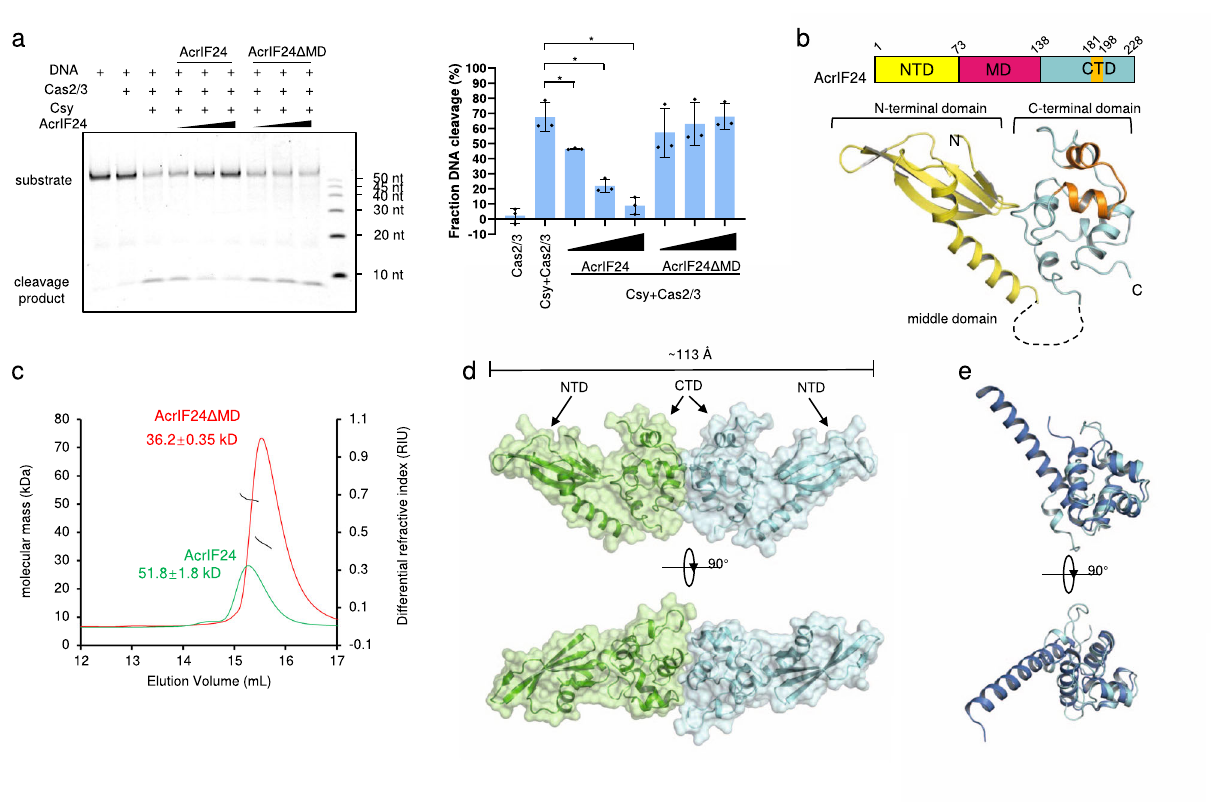
Fig. 1 The crystal structure of AcrIF24, a dimer that inhibits the type I-F CRISPR-Cas system. a AcrIF24 but not AcrIF24 Δ MD inhibits the in vitro cleavage activity of the type I-F CRISPR-Cas system. Reactions were performed with 0.32 μ M Csy complex, 0.16 μ M Cas2/3, and 0.04 μ M 54-bp dsDNA (5 ′ -FAM in the non-target DNA strand, NTS). AcrIF24 or AcrIF24 Δ MD was added with concentrations of 0.16, 0.32, and 0.64 μ M following the order indicated by the black triangles. Fraction DNA cleavage was calculated as mentioned in the Methods section. Data are presented as mean values± SD; n = 3. Two-sided t test was performed. The “ * “ indicates that there is a signi fi cant difference between the quantitative data ( P < 0.05). * P = 0.0199, 0.0018, 0.0008 (left to right). b The crystal structure of AcrIF24 is shown in the cartoon model, together with its schematic illustration. The NTD and CTD are colored in yellow and cyan, respectively. The HTH motif is colored in orange. The unmodelled MD is indicated by the dashed line and colored hot pink in the schematic illustration. c Static light scattering (SLS) studies of AcrIF24 and AcrIF24 Δ MD. The calculated molecular weights of the main peaks of the two pro fi les are shown above the peaks. d The AcrIF24 Δ MD dimer is shown in the cartoon and surface model. Two perpendicular views are shown. e Structural superimposition between AcrIF24 CTD and the clp gene regulator ClgR from Corynebacterium glutamicum (PDB: 3F51). AcrIF24 CTD and ClgR are colored in cyan and marine, respectively. Two perpendicular views are